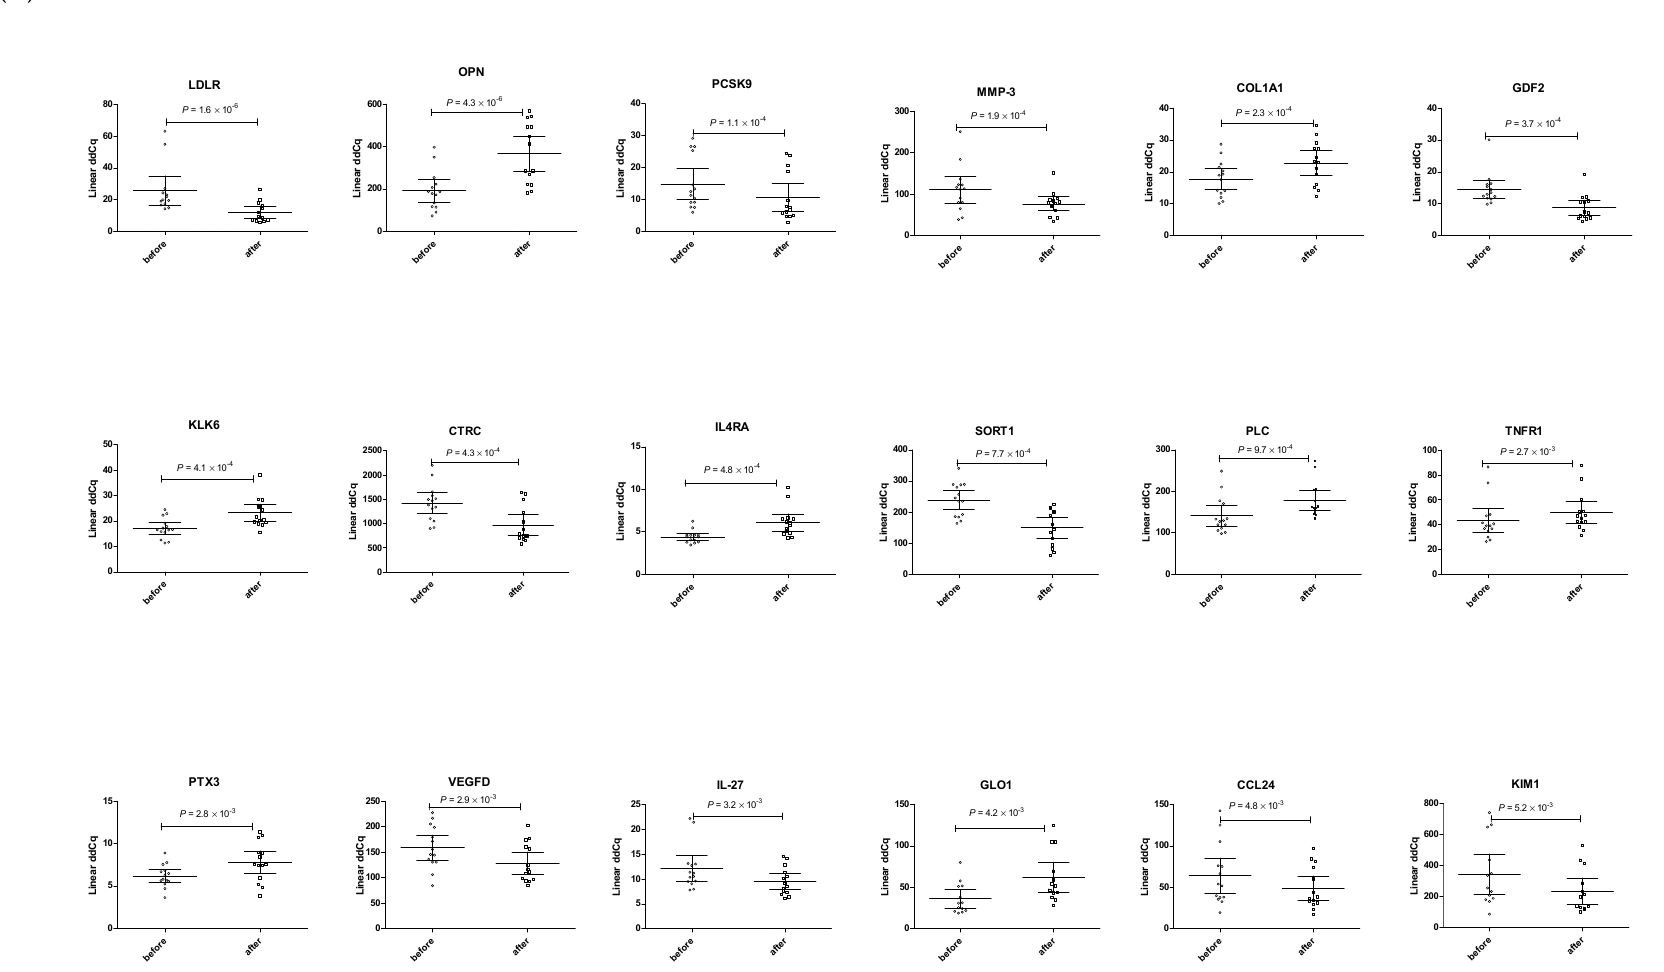
Figure 1. Distribution of plasma levels of top-deregulated protein biomarkers in response to therapies. ( A )/LLD + /AF − patients; ( B )/LLD + /AF + patients. Scatter plot, group means (before and after treatment) are indicated by horizontal bars, error bars indicate 95% CI; the significance level was set to p < 0.01.